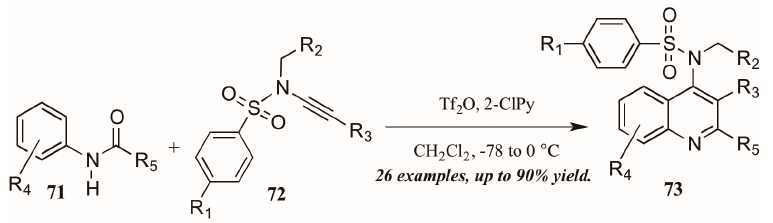
Figure 32. Electrophilic cyclization of aryl amides with sulfanyl ynamides.